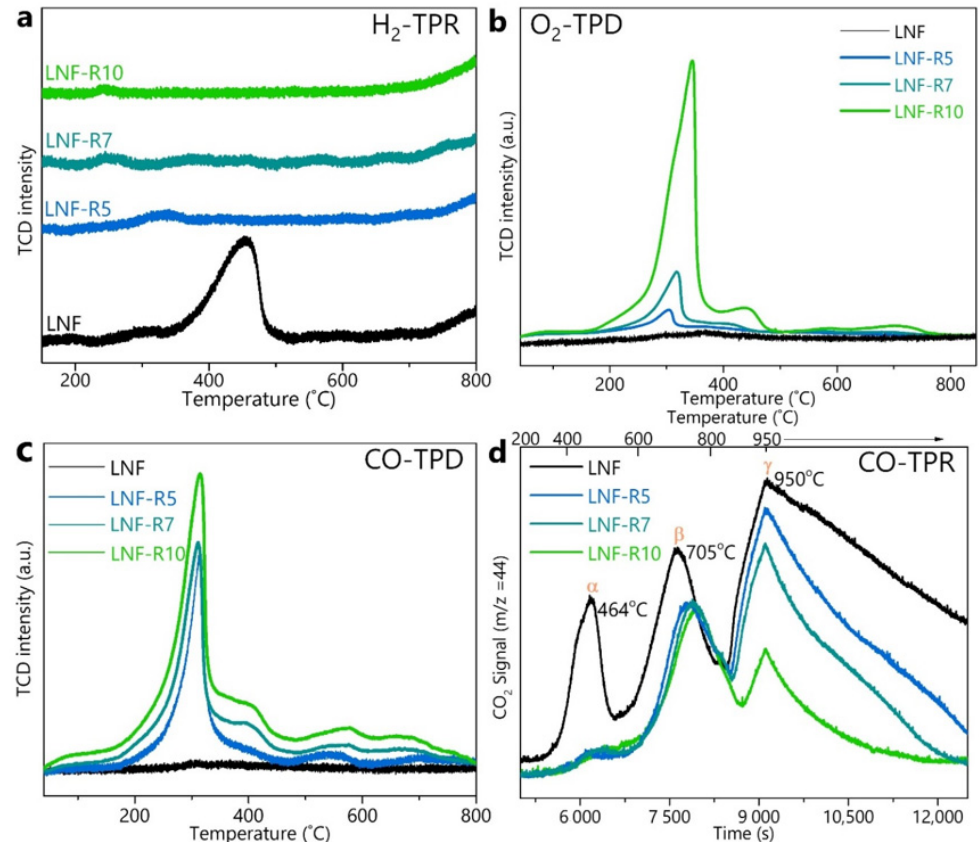
Figure 4. Temperature-programmed measurements of LNF samples before and after exsolution treatment with different reduction times. ( a ) H 2 –TPR; ( b ) O 2 –TPD; ( c ) CO–TPD; ( d ) CO–TPR.